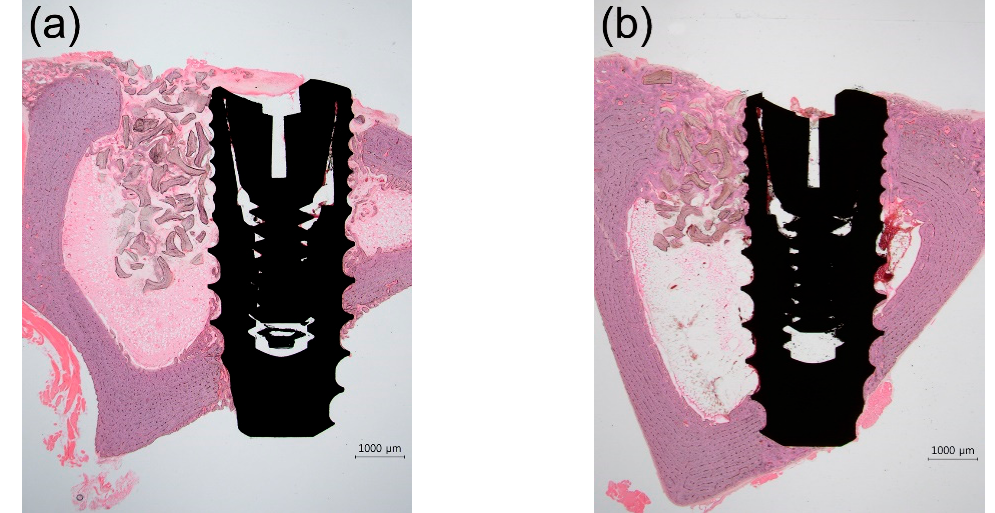
Figure 6. Representative photomicrographs (12.5× magnification) of hematoxylin- and eosin-stained histological sections of rabbit tibias at the implanted regions. ( a ) 2-week group; ( b ) 4-week group. Scale bars: 1000 μ m.